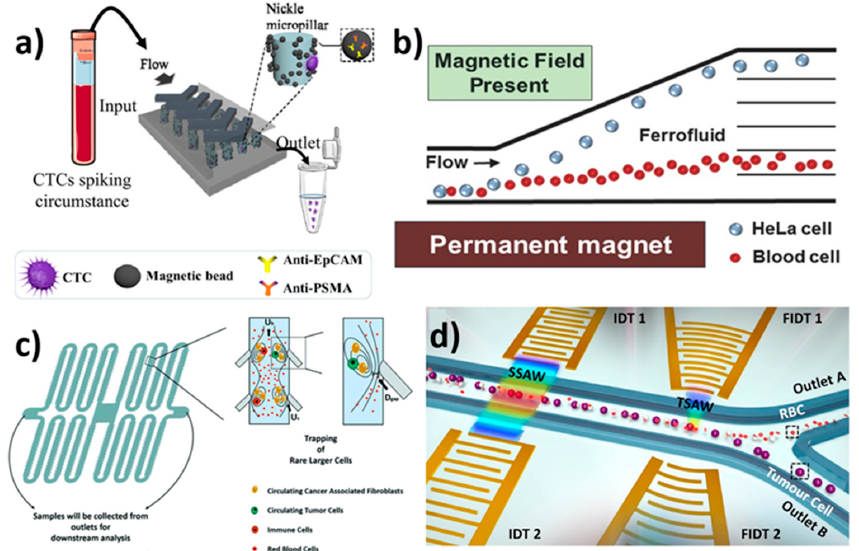
Figure 5. Schematic illustration of microfluidic devices for the isolation of CTCs using various techniques. ( a ) Schematic of the working mechanism of a dual-antibody-functionalised microfluidic device for the isolation of CTCs using magnetic beads; reprinted with permission from ref. [143], 2018, American Chemical Society. ( b ) Schematics of label-free isolation of HeLa cells in ferrofluids under magnetic fields by magnetic buoyancy forces; reprinted with permission from ref. [144], 2015, Wlsevier. ( c ) Schematic of CTC isolation in bubble-based acoustic microstreaming, which releases smaller cells by trapping larger CTCs; reprinted with permission from ref. [103], 2020, Royal Society of Chemistry. ( d ) Schematic illustration of a multi-stage device consisting of a pair of IDTs and FIDTs to generate SSAWs and TSAWs for the isolation of CTCs; reprinted with permission from ref. [151], 2018, Elsevier.